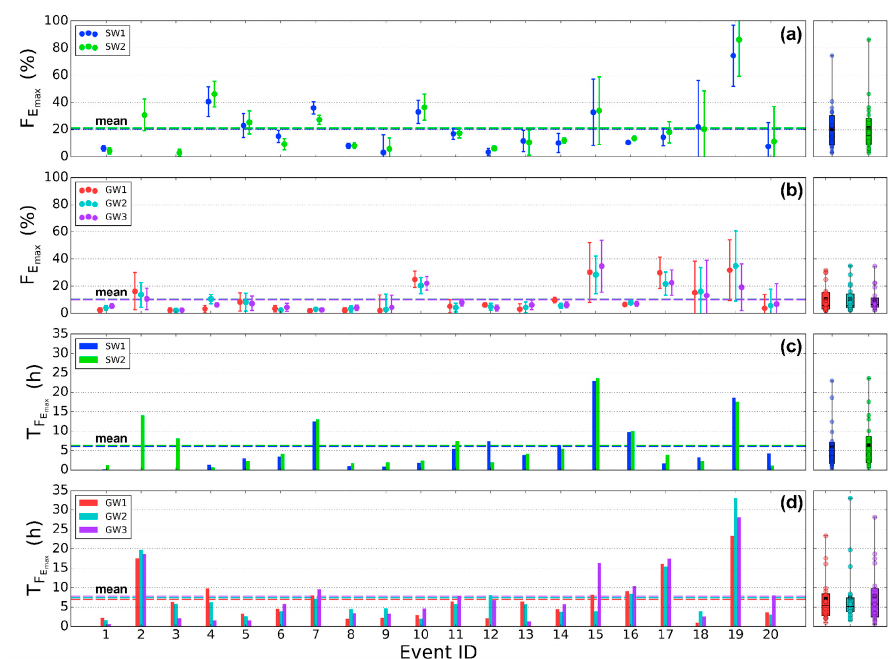
Figure 7. ( a , b ) Maximum event water fraction F E for stream water (SW) and groundwater (GW) sources, including the uncertainty of estimations (error bars) and ( c , d ) response time of maximum event water fraction T F for the same water sources. SW1 was not sampled at event #2 and #3. Boxplots (right panels) represent the interquartile range, black bars the median, black squares the mean and the whiskers the range of all 20 events.